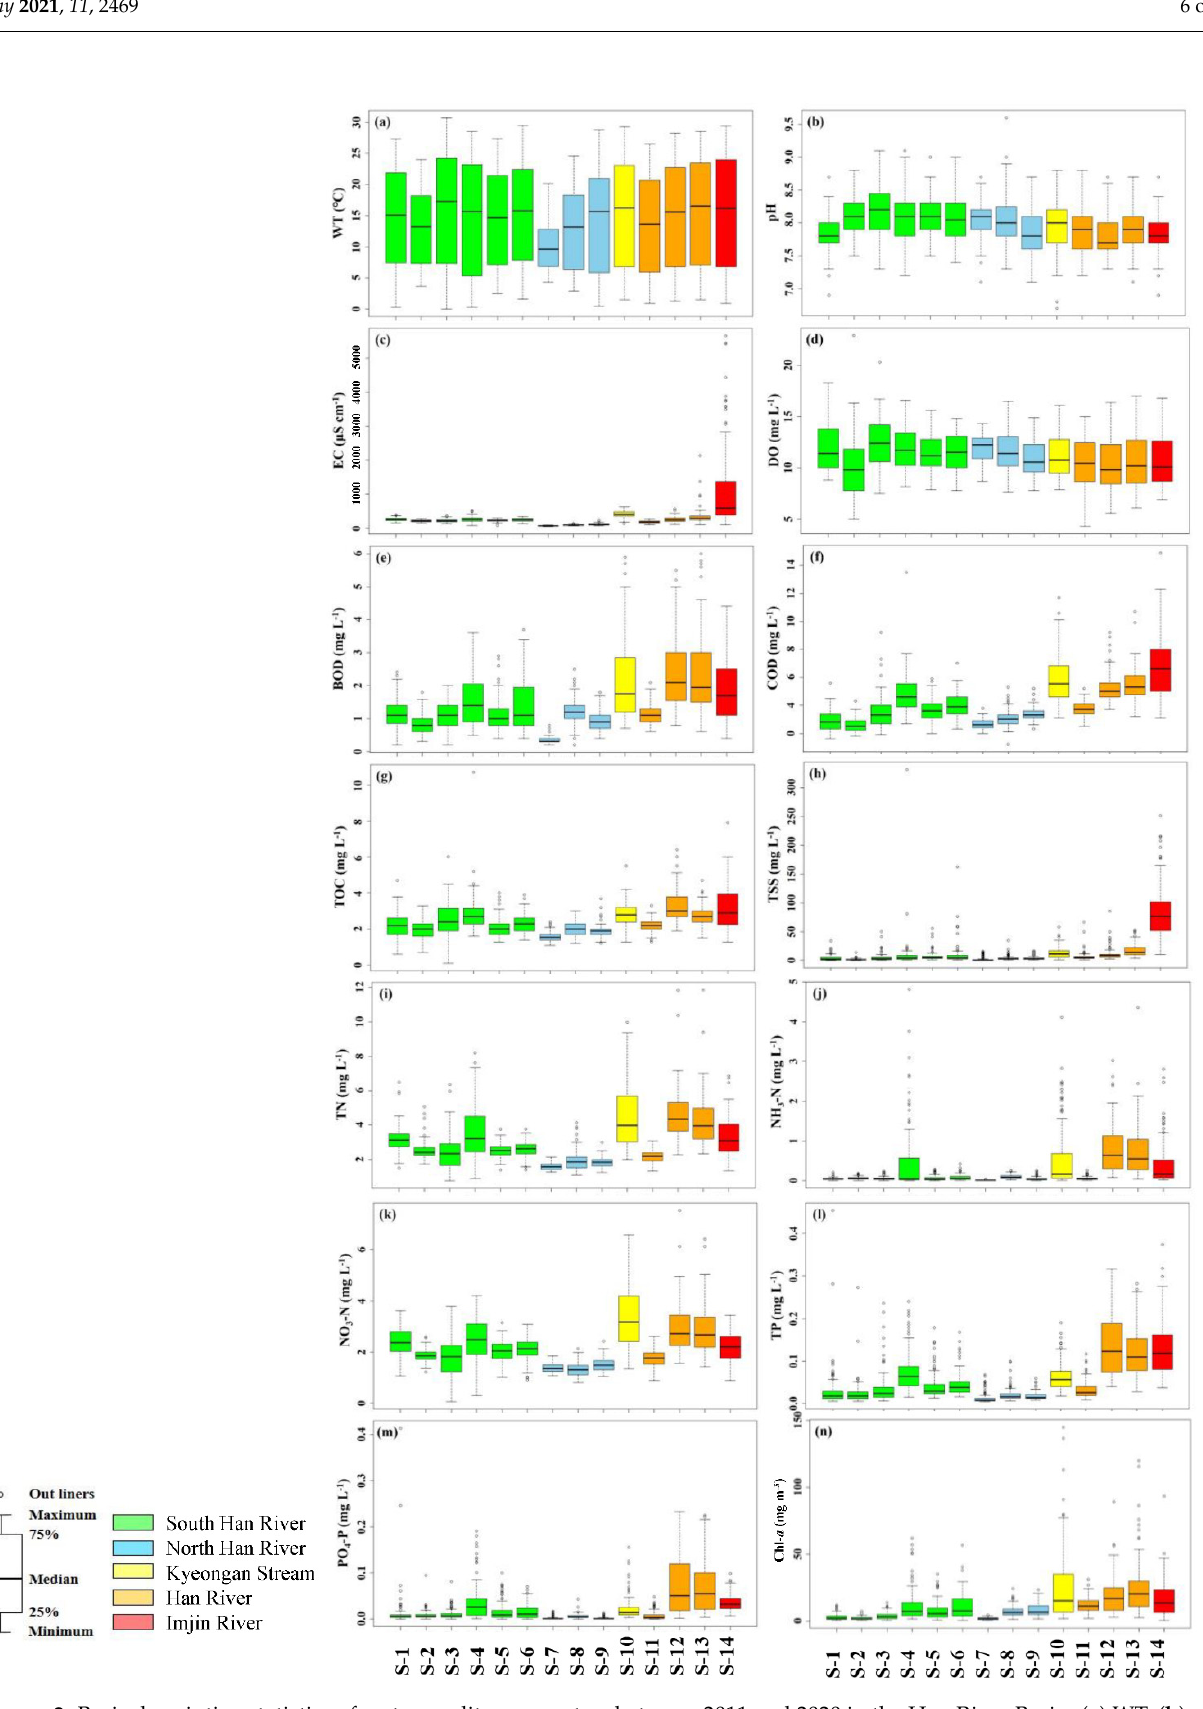
Figure 2. Basic descriptive statistics of water quality parameters between 2011 and 2020 in the Han River Basin. ( a ) WT, ( b ) pH, ( c ) EC, ( d ) DO, ( e ) BOD, ( f ) COD, ( g ), TOC, ( h ) TSS, ( i ) TN, ( j ) NH 3 -N, ( k ) NO 3 -N, ( l ) TP, ( m ) PO 4 -P, ( n ) Chl- a .